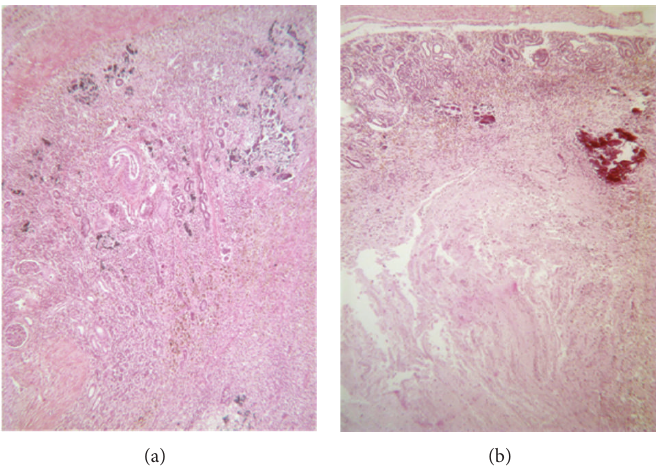
Figure 3: Necrosis of the left adrenal gland with asymmetrical bilateral renal impairment and signs of ischemic and hemorrhagic lesions. The renal capsule was thickened on both sides with fibrosis extending to the perirenal brown fat.